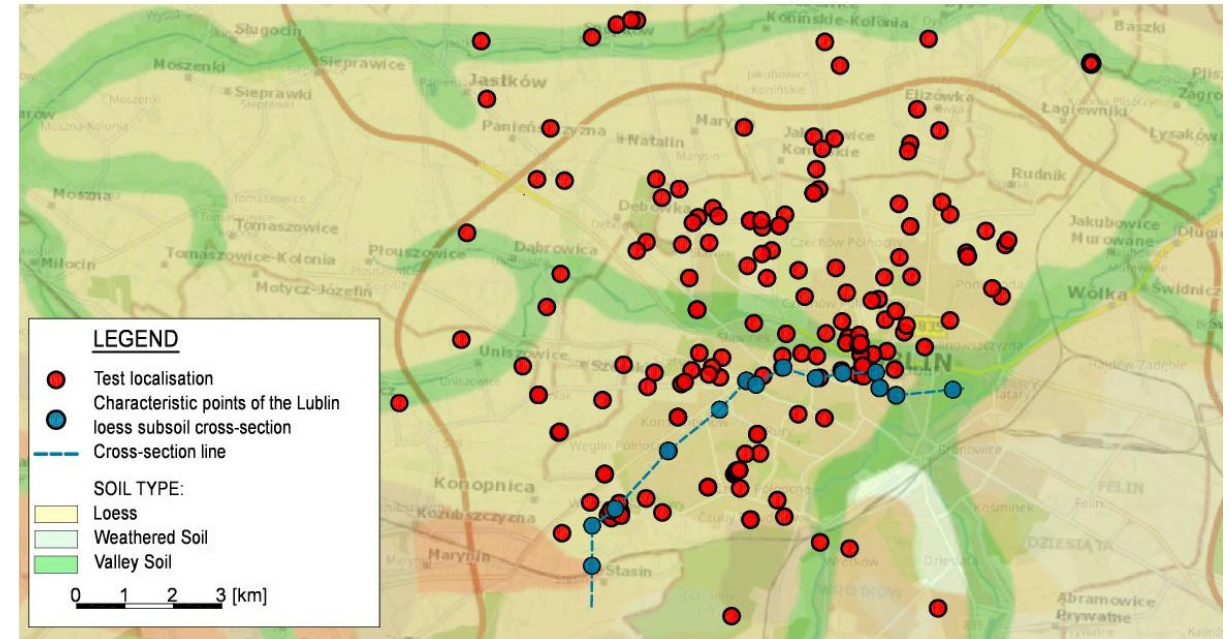
Figure 2. Location of test points used to plot the subsoil cross-section.